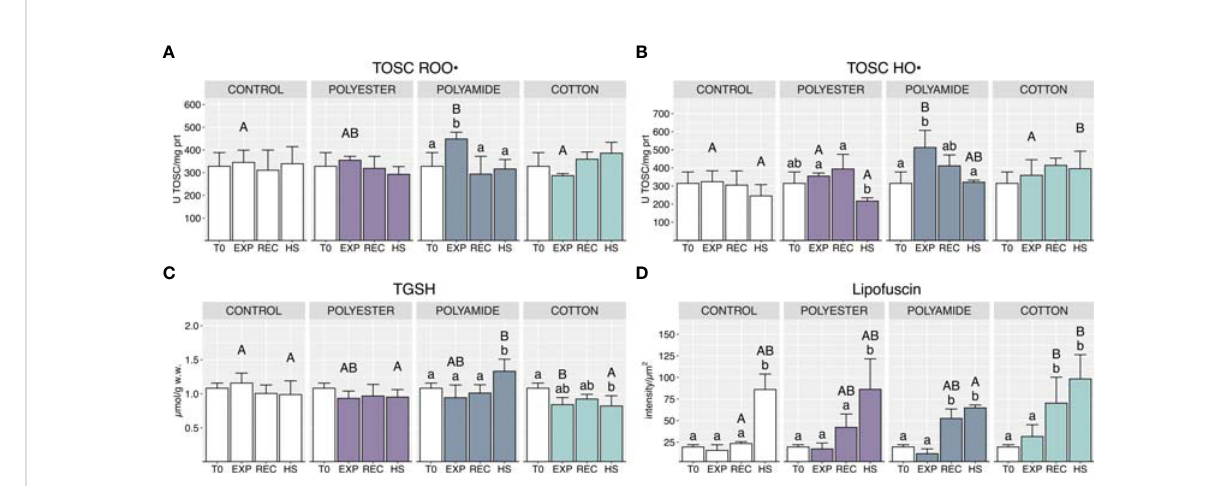
FIGURE 5 Total oxyradical scavenging capacity toward peroxyl radical (A) and hydroxyl radical (B) , total glutathione (C) and lipofuscin content (D) in control and polyester, polyamide or cotton-exposed mussels measured at T0 and at the end of each experimental phase (EXP, end of MFs- exposure; REC, recovery after MFs-exposure; HS, heat-stress after the MFs-exposure). Upper case letters highlight differences among treatments within the same experimental phase; lower case letters highlight differences among different experimental phases of the same treatment. Values are given as mean ± SD